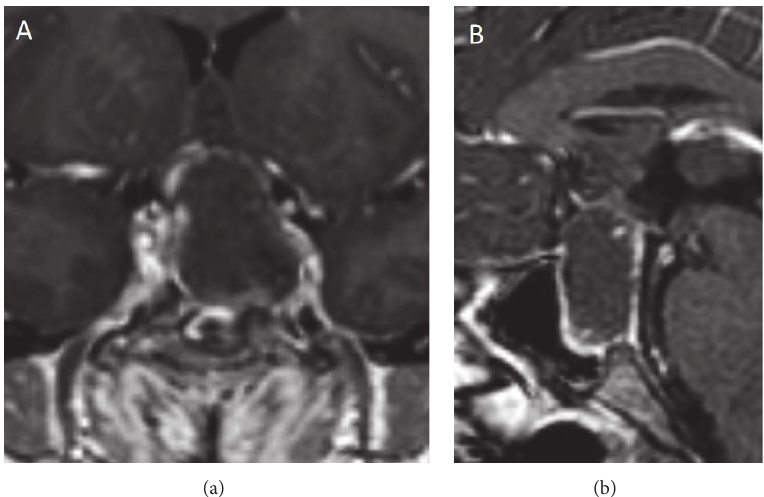
Figure 4: Coronal (a) and sagittal (b) T1-weighted MRI images after gadolinium administration show a moderate “ring” enhancement in a patient with pituitary